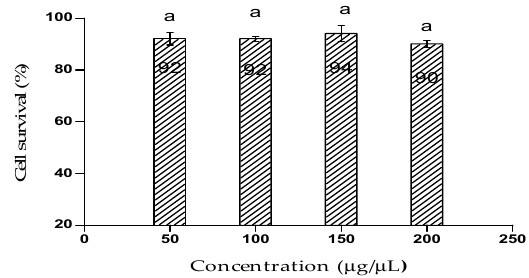
Figure 4. Cytotoxic effect of the bioflocculant on Caco2 cells. The letter (a) denotes statistical significance at p < 0.05.